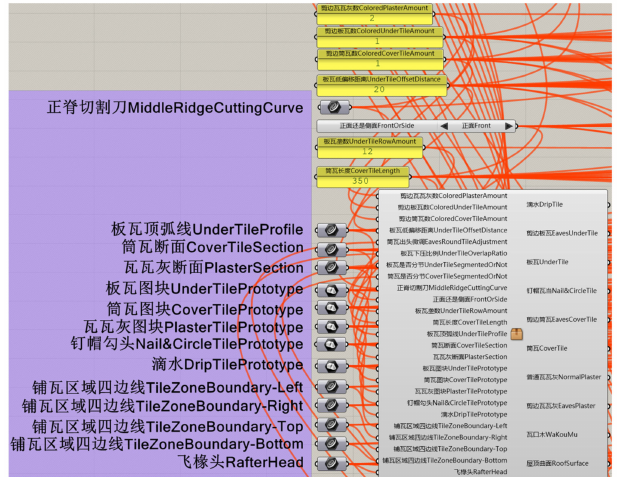
Figure 24. Selections of parameters.